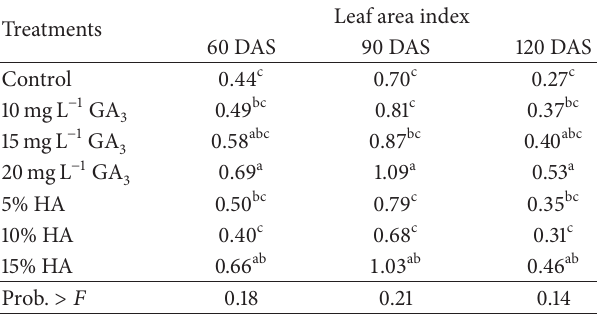
) and humic acid 3